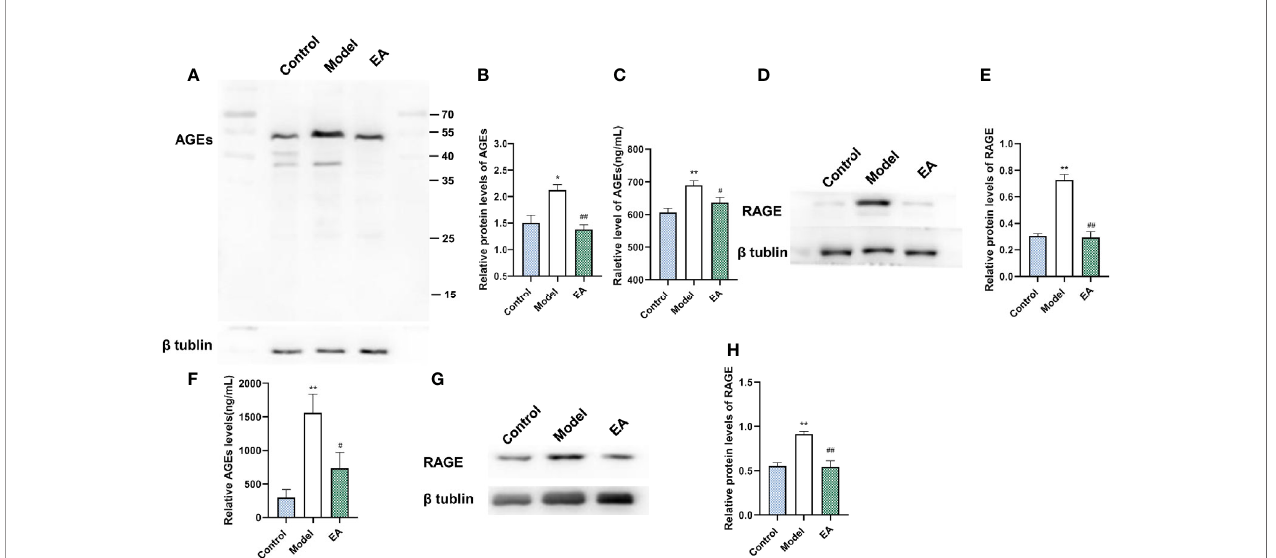
FIGURE 5 | Effect of EA on the expression of AGEs and RAGE in footpad skin and sciatic nerve. (A) Representative Western blot analysis of AGEs staining and (B) relative protein levels in footpad skin (n = 3, *p < 0.05, ## p < 0.01). (C) Representative ELISA analysis of AGEs in footpad skin (n = 3, **p < 0.01, # p < 0.05). (D) Representative Western blot analysis of RAGE staining and (E) relative protein levels in footpad skin (n = 3, **p < 0.01, ## p < 0.01). (F) Representative ELISA analysis of AGEs in the sciatic nerve (n = 3, **p < 0.01, # p < 0.05). (G) Representative Western blot analyses of RAGE staining and (H) relative protein levels in the sciatic nerve (n = 3, **p < 0.01, ## p <